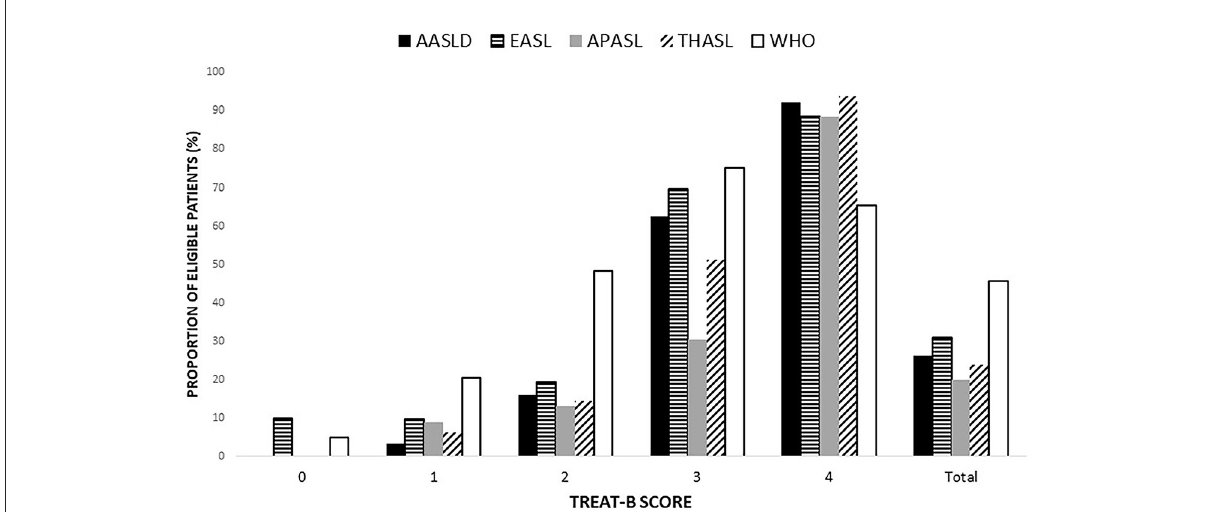
FIGURE2 Proportion of patient eligible for treatment based on each of the international guidelines, expressed as a total point of TREAT-B (Data are shown in percentage). AASLD, the American association for the study of the liver; APASL, the Asian pacific association for the study of the liver; EASL, the European association for the study of the liver; THASL, the Thai association for the study of the liver; WHO, World Health Organization.